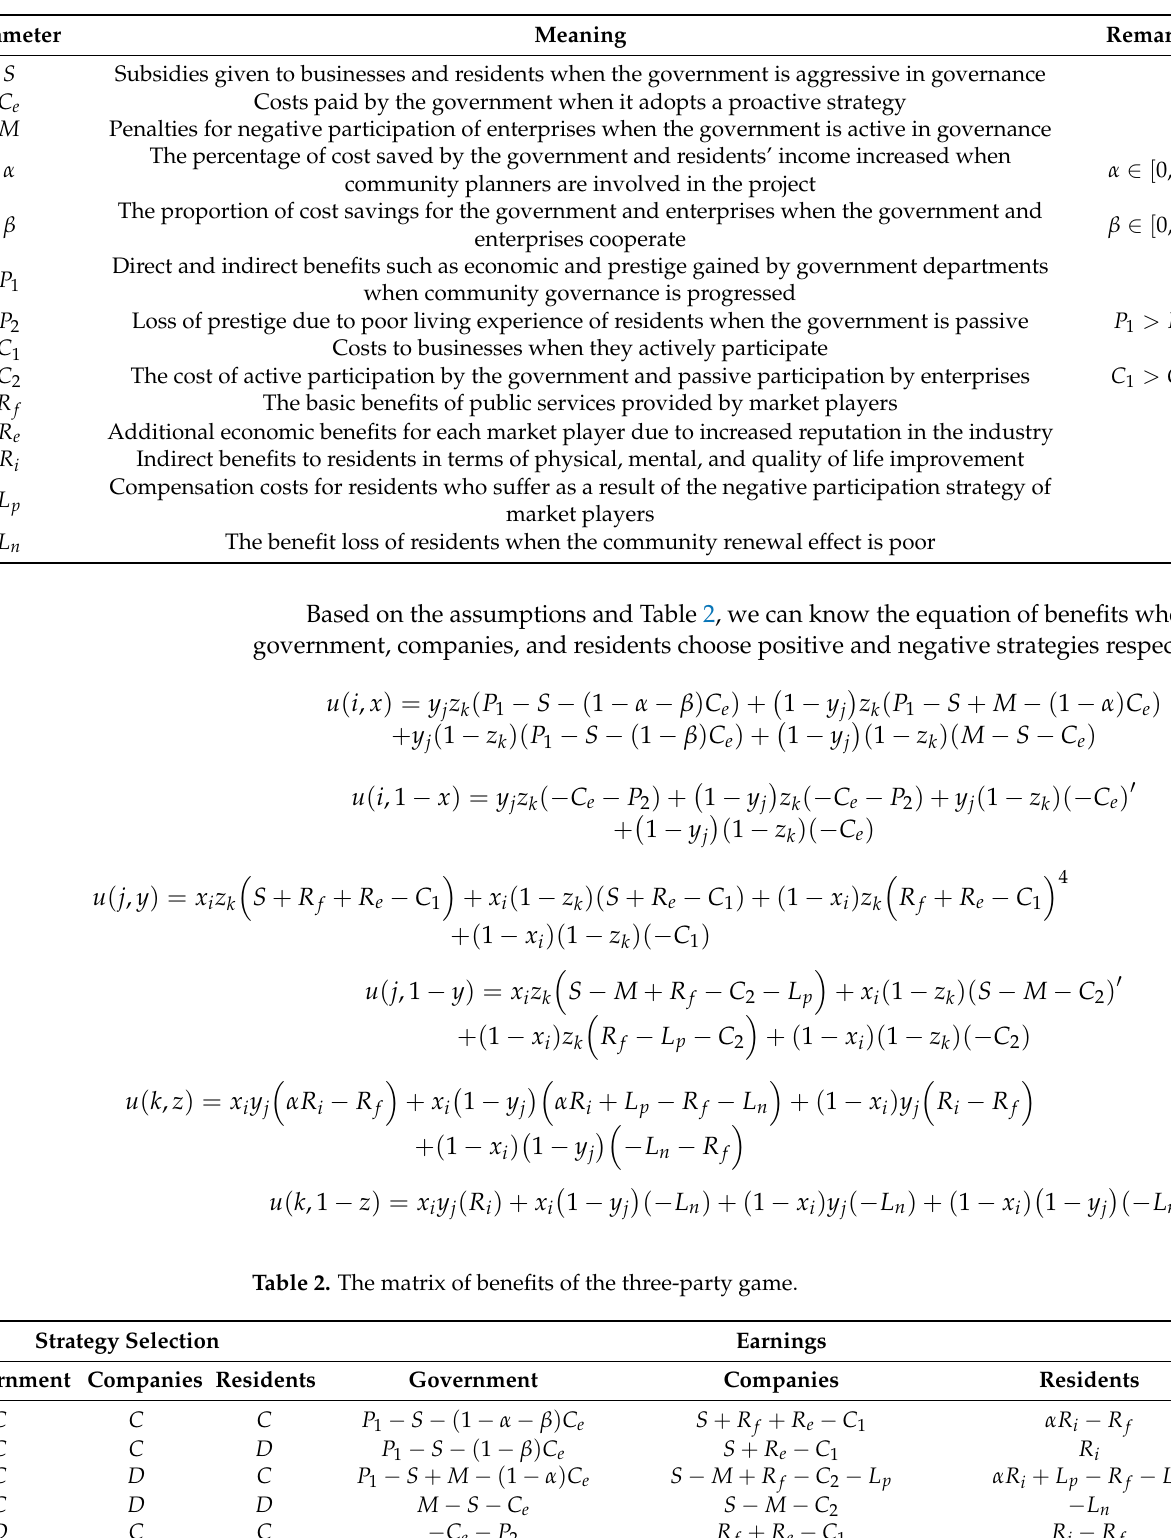
Table 1. Parameter setting table of the three-party game.